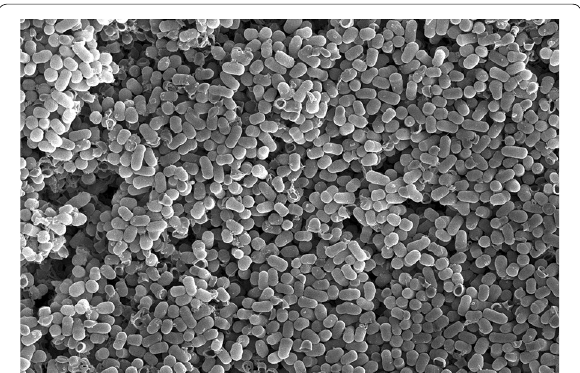
Fig. 1 Morphology of strain EPI‑7 T viewed by SEM